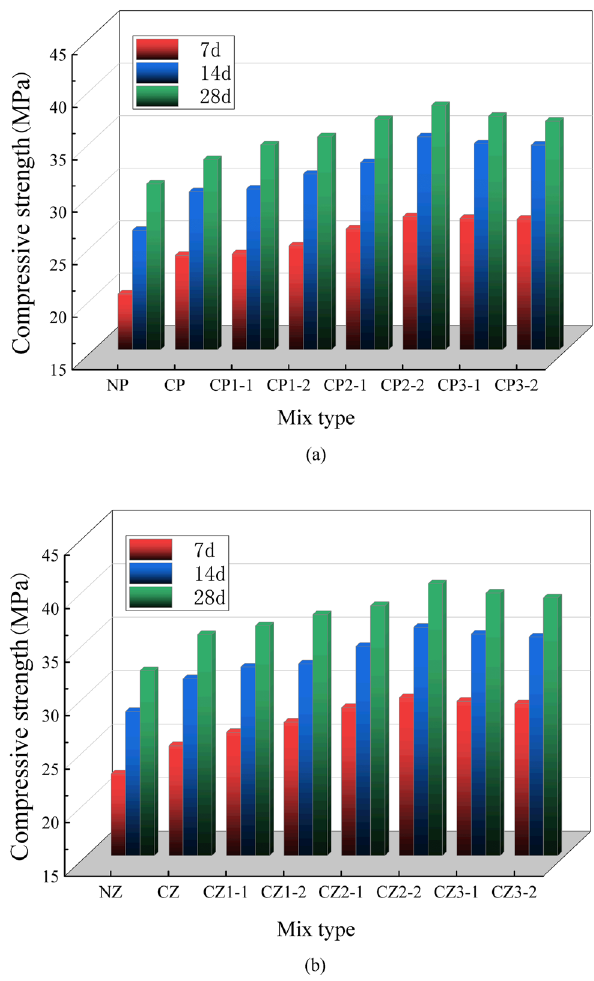
Figure 4: Compressive strengths of the RAC at various ages. ( a ) Ordinary mixing mode and ( b ) vibration mixing